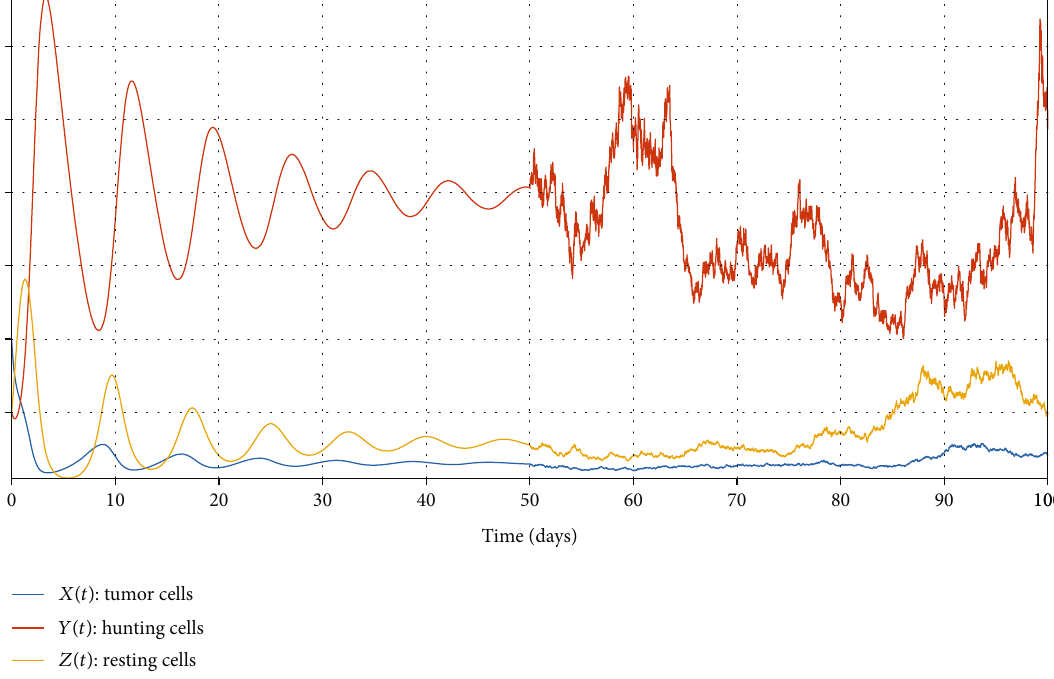
= 0 : 9 , c = 0 : 65 , c = 0 : 21 , c = 0 : 55 , c = 0 : 62 , c = 0 : 39 , c 1 2 3 4 5 6 7